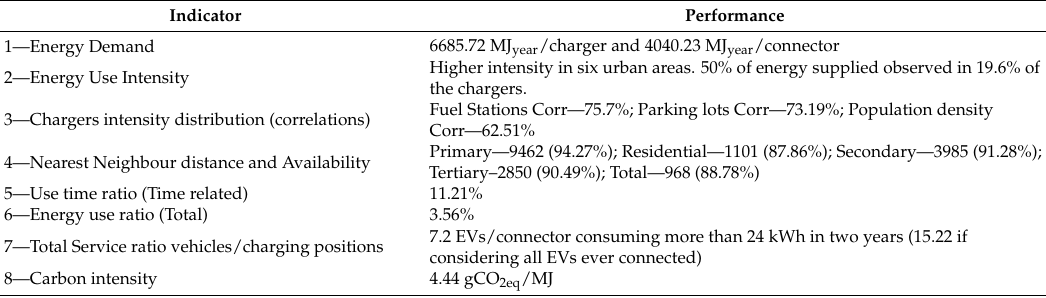
Table 4. Summary of all charging infrastructure indicators analysis. EVs—electric vehicles